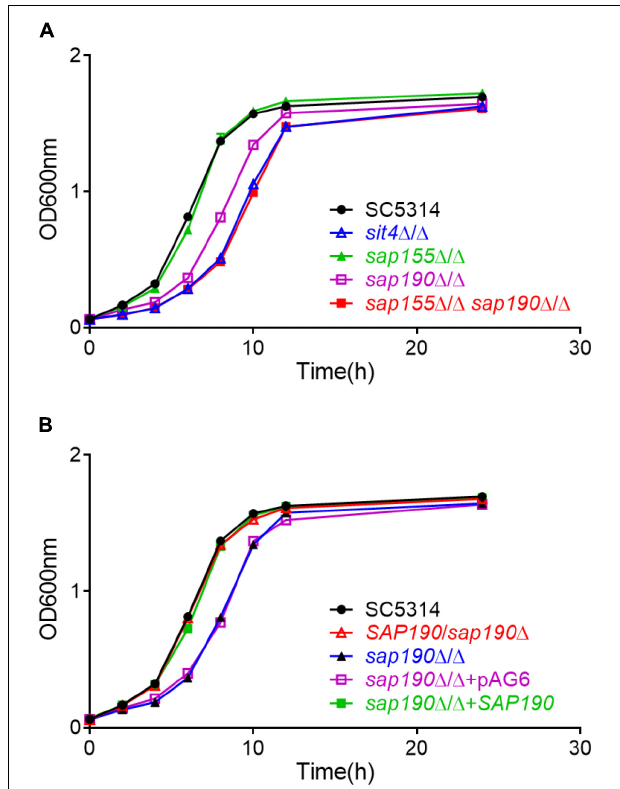
FIGURE 2 | The growth of Candida albicans strains of the indicated genotype in YPD medium. Growth curves of (A) C. albicans SC5314, sit4 (cid:49) / (cid:49) , sap155 (cid:49) / (cid:49) , sap190 (cid:49) / (cid:49) , and sap155 (cid:49) / (cid:49) sap190 (cid:49) / (cid:49) strains and (B) C. albicans SC5314, SAP190 / sap190 (cid:49) , sap190 (cid:49) / (cid:49) , sap190 (cid:49) / (cid:49) + pAG6, and sap190 (cid:49) / (cid:49) + SAP190 strains in liquid YPD medium at 30 ◦ C with shaking at 200 rpm. All experiments were repeated using at least 3 independent clones for each